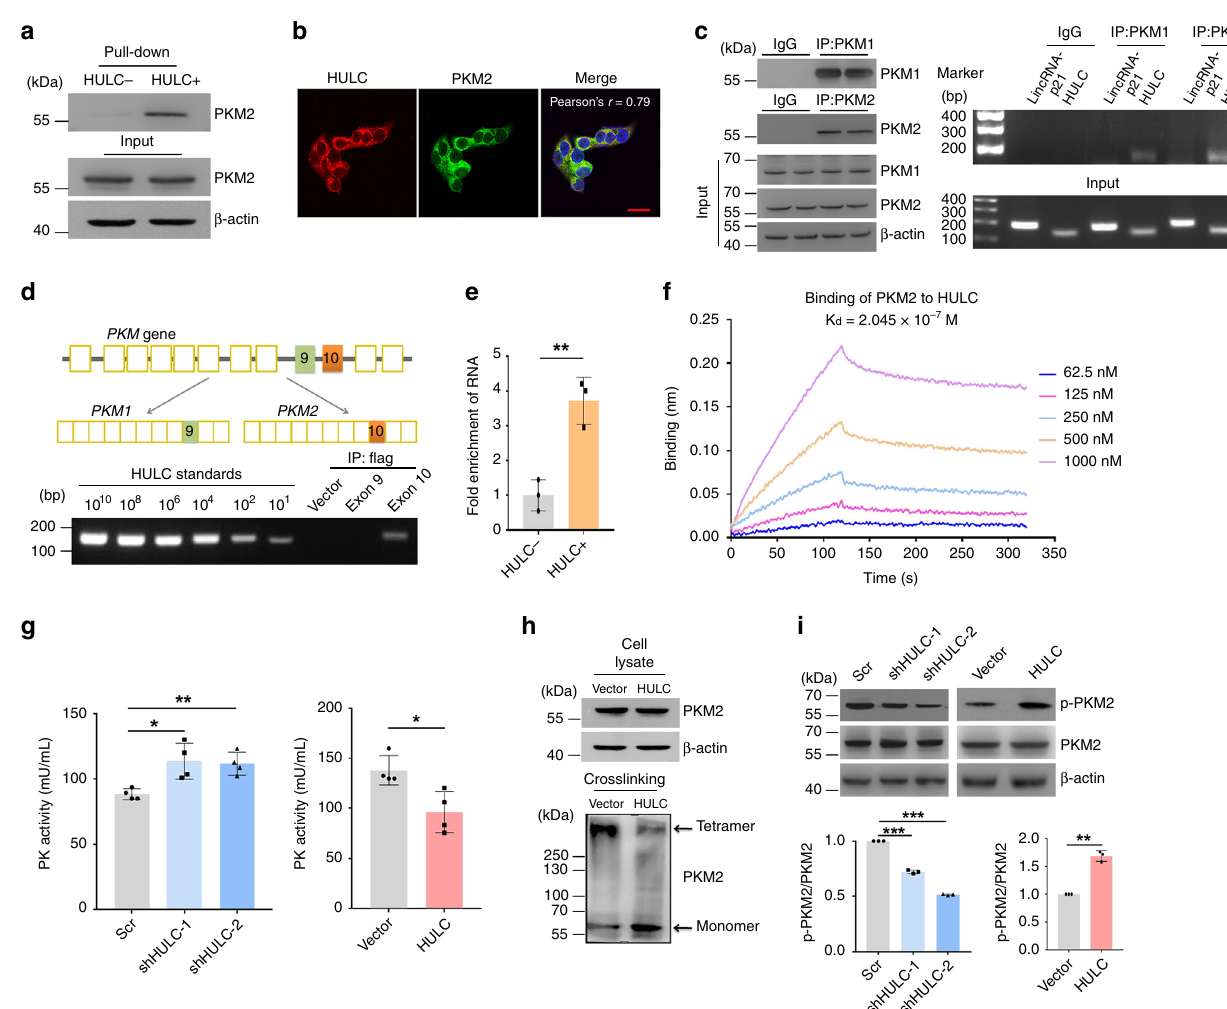
Fig. 4 HULC interacts with the glycolytic enzyme PKM2. a Biotinylated HULC and antisense HULC were synthesized by in vitro transcription and incubated with HepG2 cell lysates, respectively. The RNA-protein complexes were isolated with streptavidin-conjugated beads. PKM2 in the pull down was examined by western blotting. Biotinylated antisense HULC was used as the control. b The cellular localizations of HULC and PKM2 were analyzed by RNA-FISH combined with immuno fl uorescence. Cell nuclei were stained with DAPI, and the scale bar was 20 μ m. c Immunoprecipitation of PKM1 and PKM2. The left panel shows the immunoblots of PKM1 and PKM2 in the cell lysate and immunoprecipitates. The right panel shows the agarose gel electrophoresis images of the qRT-PCR products of HULC. LincRNA-p21 was examined as RNA control. d Binding of HULC to fl ag-tagged exon 9 (PKM1 speci fi c) and exon 10 (PKM2 speci fi c) as determined by the RIP assay. e His-tagged rPKM2 was fi rst immobilized to Dynabeads ® His-tag isolation magnetic beads, and then incubated with in vitro transcribed HULC or antisense HULC. The RNA-protein complexes were isolated, and the levels of HULC were examined by qRT-PCR. Data represent the mean ± s.d. of triplicate independent experiments (*** P < 0.001, by two-sided Student ’ s t test). f The molecular interaction between PKM2 and HULC was to measure the K d value. g The PK activities of HepG2 cells with HULC knockdown (left panel) or overexpression (right panel) were measured by a PK activity assay kit and compared with the same number of corresponding control cells. Data represent the mean ± s.d. ( n = 4 independent experiments, * P < 0.05, by two-sided Student ’ s t test). h Western blotting of PKM2 in cells with or without crosslinking. In vivo crosslinking was performed by incubating the cells with 1 mM disuccinimidyl suberate (DSS) at room temperature for 30 min. i HULC was knocked down or overexpressed in HepG2 cells. The levels of p-PKM2 (Y 105 ) and PKM2 in the cell lysates were detected by western blotting. Band intensities were measured by ImageJ. Data represent the mean ± s.d. of triplicate independent experiments (** P < 0.001, *** P < 0.001, by two-sided Student ’ s t test). Source data are provided as a Source data fi